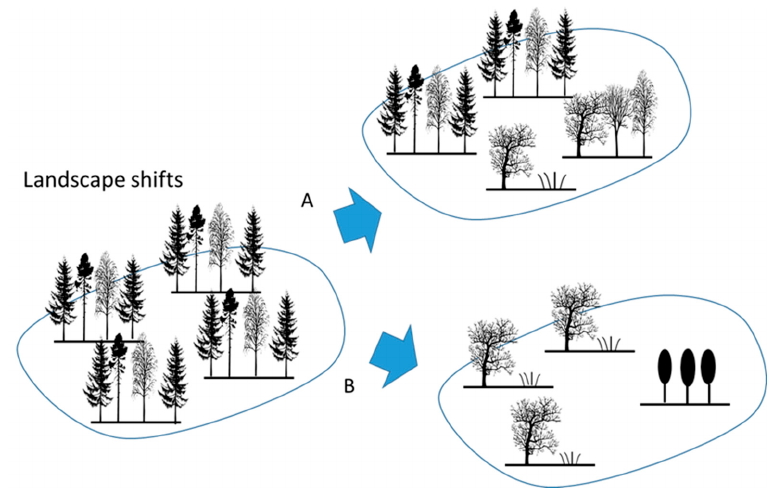
Figure 1. Landscape shifts for southern boreal forest for future scenarios with low and high magnitudes of climate warming. A . Low magnitude of warming allows some boreal stands to persist while other stands convert to temperate forest or savanna; this is a moderate resilience scenario. B . High magnitude of warming causes loss of all boreal stands and their replacement by either savanna or artificial planted forest; this is a low resilience scenario.